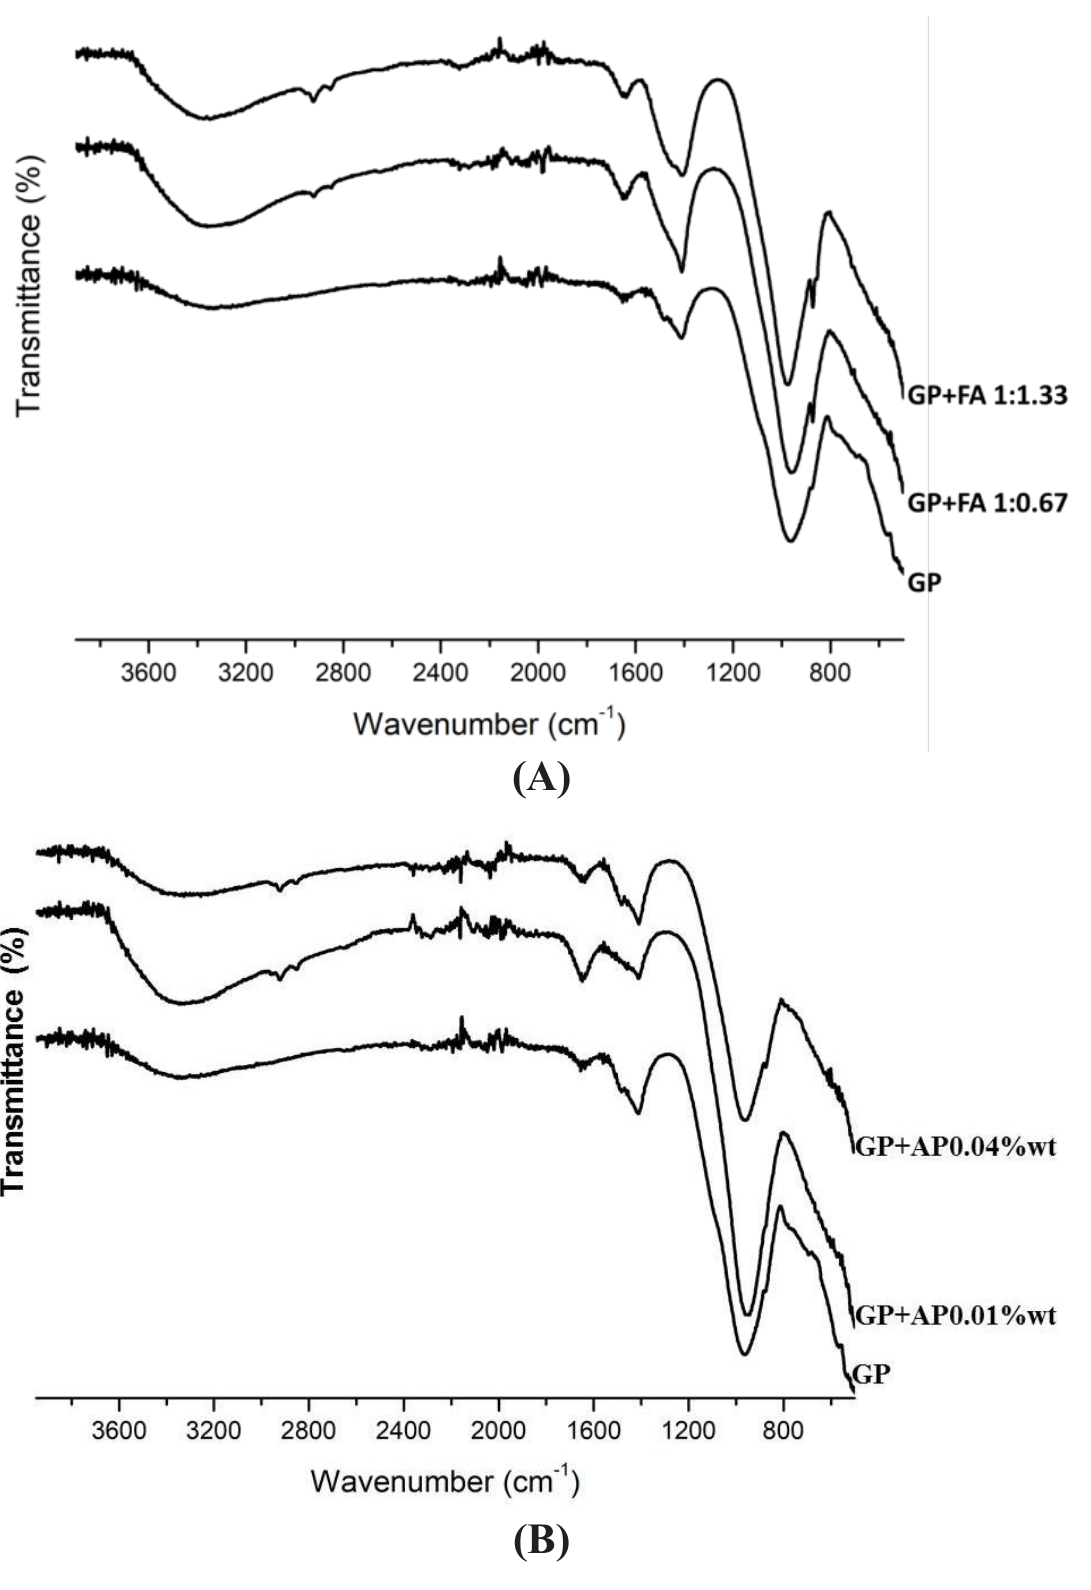
Figure 2: FTIR spectra of (A) lightweight geopolymer without and with foaming agent addition with ratio of 1.5:1 and 1.5:2; (B) lightweight geopolymer without and with aluminum powder addition with ratio of 0.01 %wt and 0.02